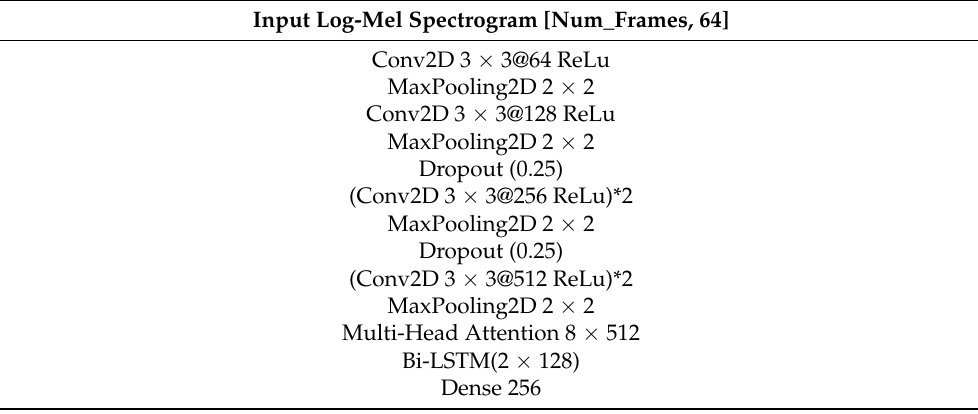
Table 1. Phase feature selection method based on